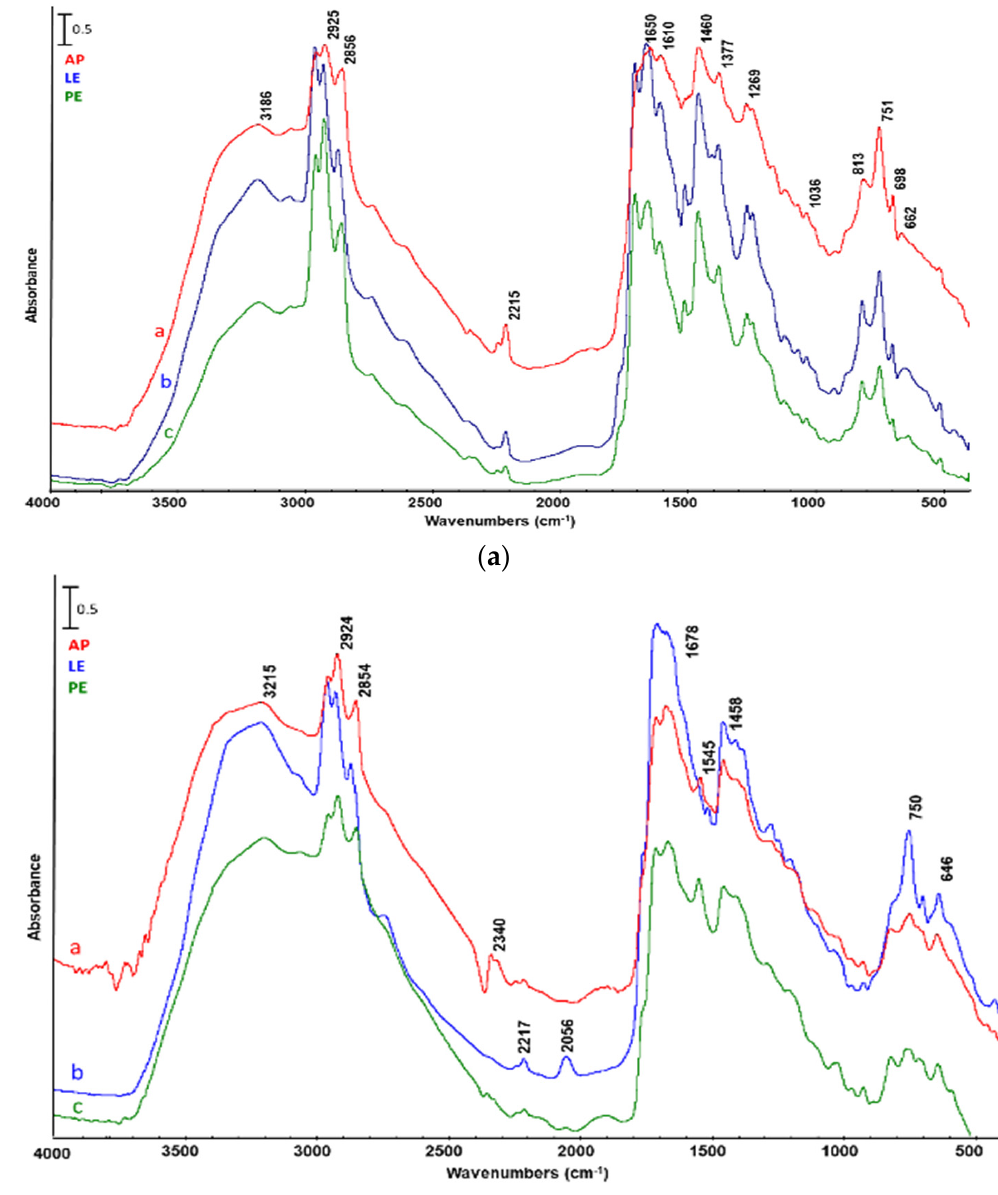
Figure 5. FTIR analysis of light reaction liquid from catalytic pyrolysis of a— Arthrospira platensis untreated biomass (AP), b—biomass after lipid extraction (LE), and c—biomass after protein extraction (PE). Catalyst: ( a ) ZSM5, ( b ) silica–alumina.